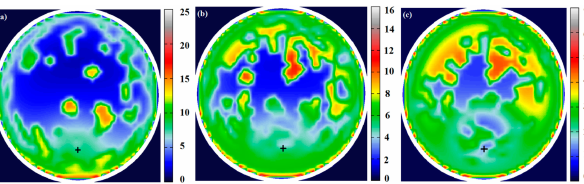
Figure 2. Sky luminance distribution under broken cloud arrays (kcd / m 2 ) computed using the UniSky simulator for a solar altitude at 30 ◦ and cloud fractions as follows: ( a ) 0.15, ( b ) 0.30, and ( c )